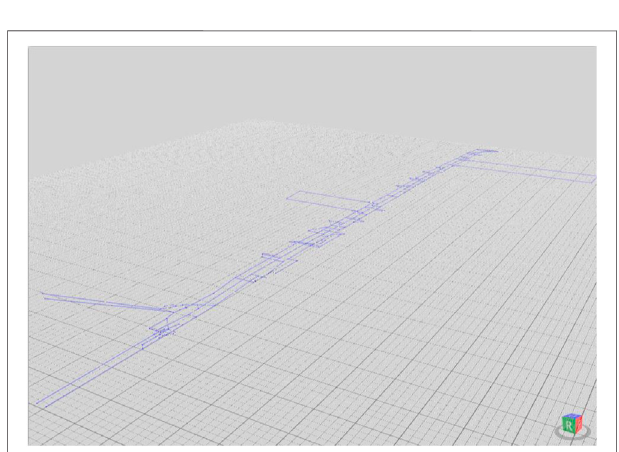
FIGURE 6 | Ventilation system diagram of Wangjialing mine.